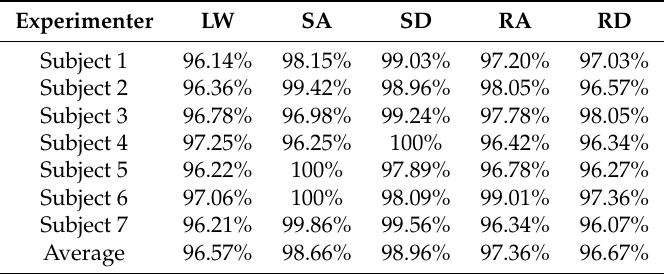
Figure 10. Confusion matrix of the steady locomotion period. Table 1. The recognition accuracy of five different